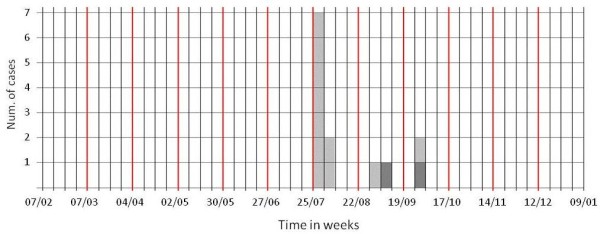
Epidemic curve indicating the week when each of 13 incident cases was identified (i.e.: first anti-HCV positive test). In particular 7 cases where reported on 27 July, 2 on 3 August, 1 on 30 August, 1 on 8 September 1 on 27 September and 1 on 28 September (case occurred on 27 and 28 September were reported on the same week). Light grey squares indicate cases who underwent HD in the afternoon shift of the 20 April 2005. Dark grey squares are for subjects who did not undergo HD in the afternoon shift of the 20 April 2005. Red lines define a four week periods.